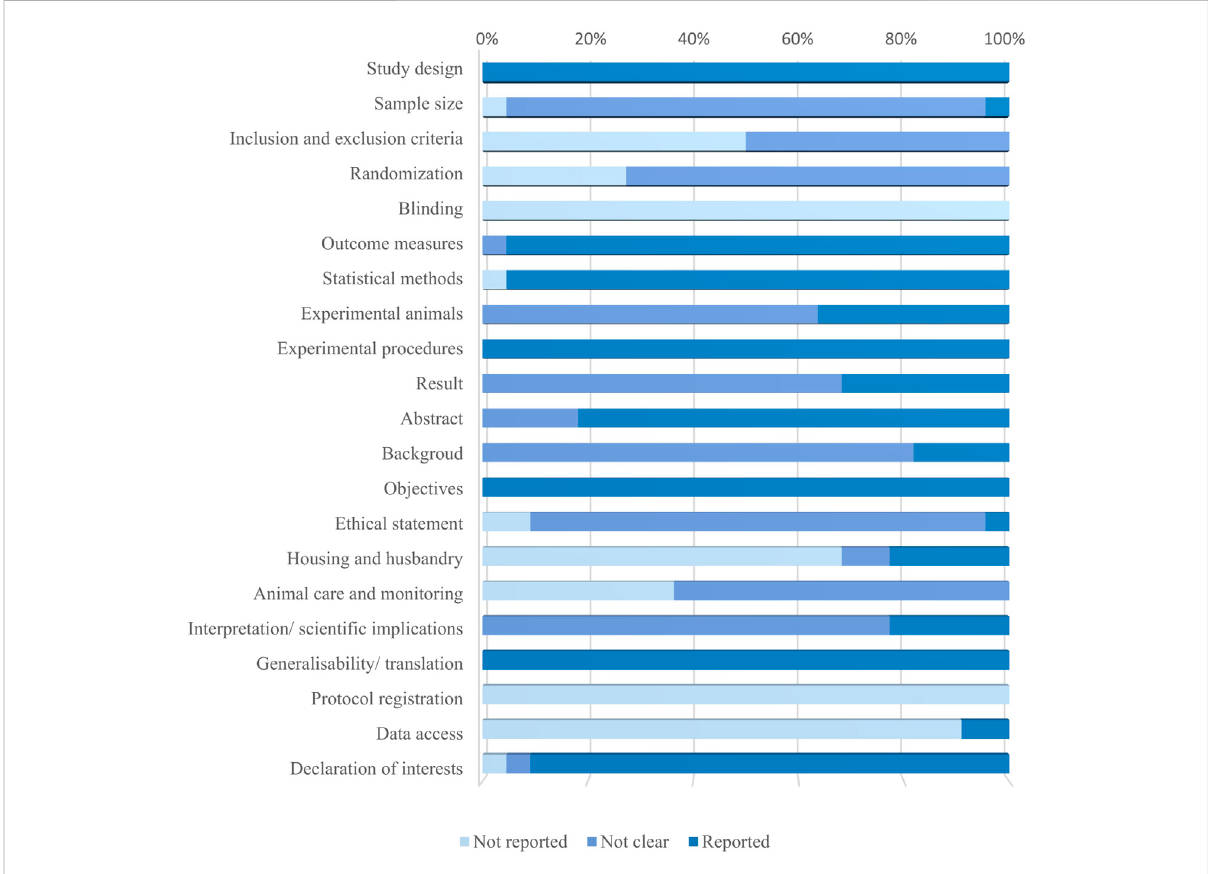
FIGURE 3 Resultsofthequalityassessmentof22studiesapplyingARRIVE2.0guidelines.Thebargraphshowsthepercentagefrequenciesof21items.Itis to be noted that the former 10 items belong to the essential set, whereas the latter 11 are in the recommendation